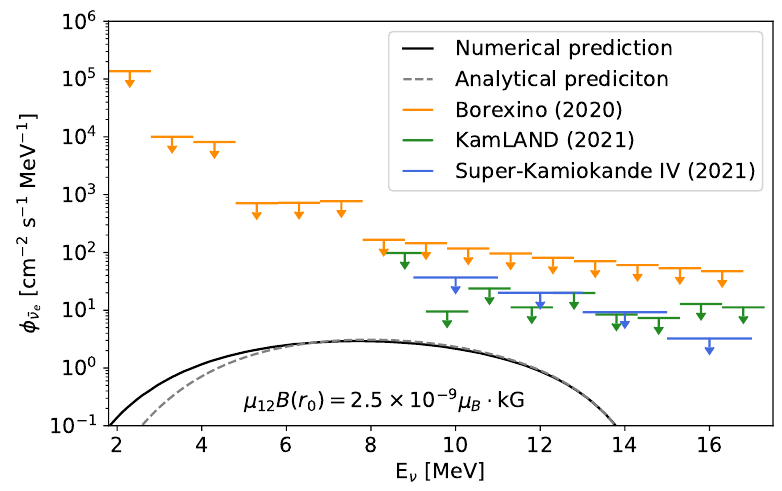
Figure 7 . Model-independent limits on ¯ ν e flux of astrophysical origin, as reported by KamLAND [20], Borexino [22] and Super-Kamiokande [23, 30]. For comparison, we show the expected solar ¯ ν e flux for µ 12 B ⊥ ( r 0 ) = 2 . 5 × 10 − 9 µ B kG for the AGSS09 SSM, from our analytical and numerical